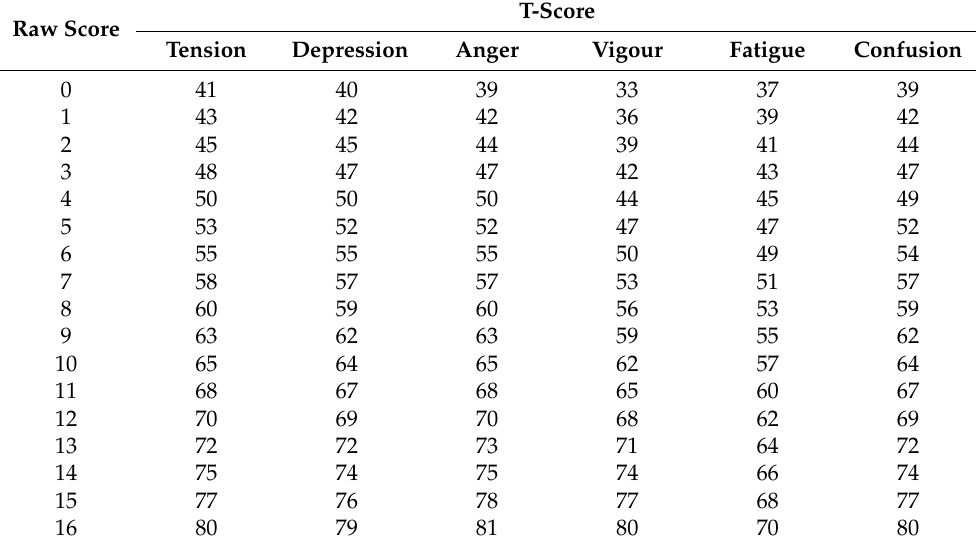
Table 8. MASMS normative scores for the female non-athlete sample ( n = 1046). Raw